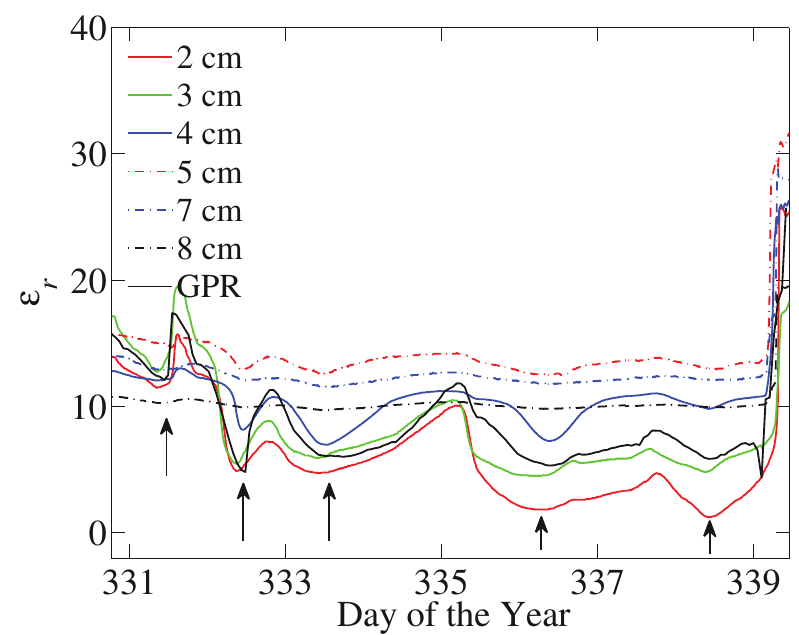
Figure 6. Time series of the relative permittivity ( ε r ) of the soil recorded at shallow depths (2, 3, 4, 5, 7, 8 cm) and estimated from time-lapse GPR data. Five freezing and thawing cycles can be clearly observed over a period of nine days, as indicated by